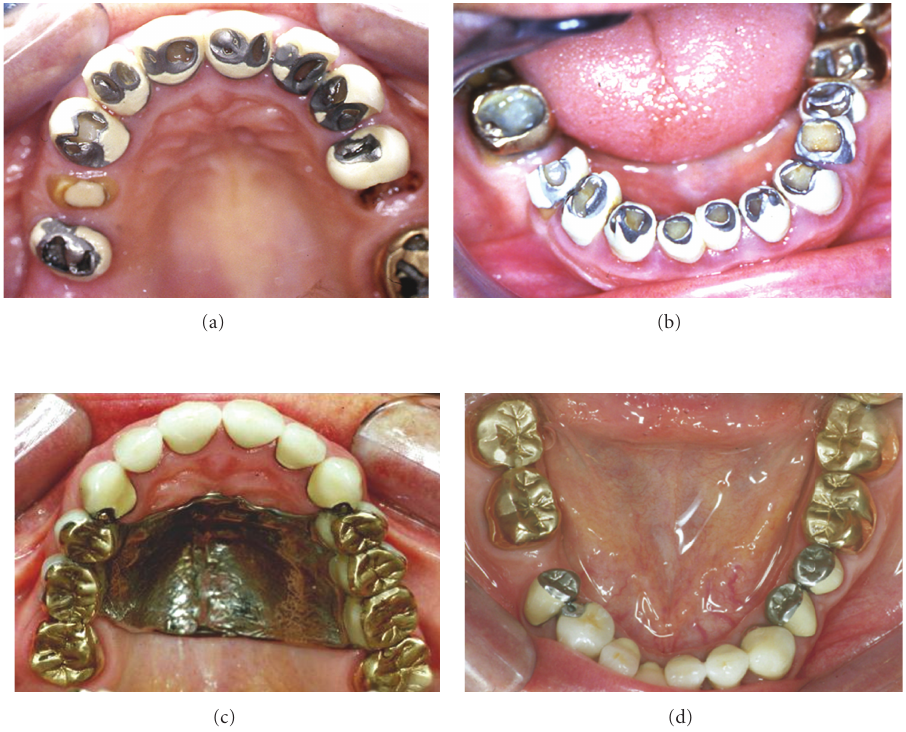
Figure 4: Photographs of (a, b) extensively abraded crowns and (c, d) the subsequent treatment.